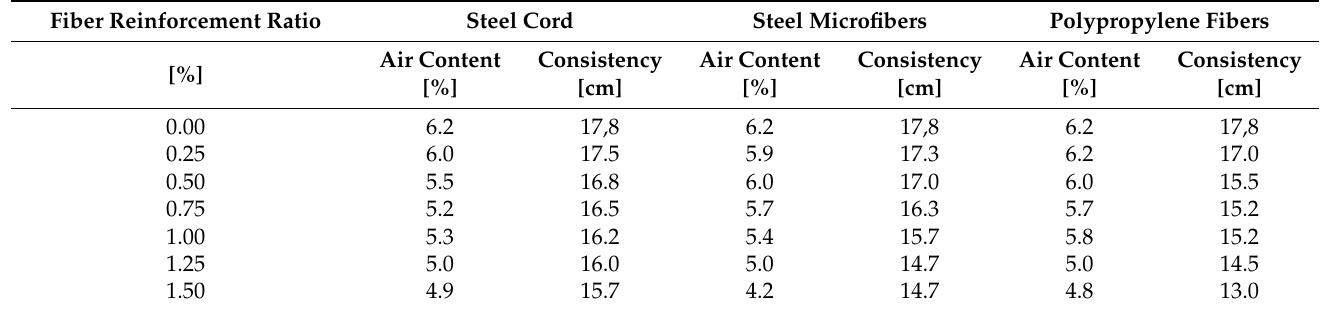
Figure 3. ( a ) Test of the air content in the fresh mixture, ( b ) test of the consistency of the fresh mixture: cone method. Table 3. Fresh mixture test